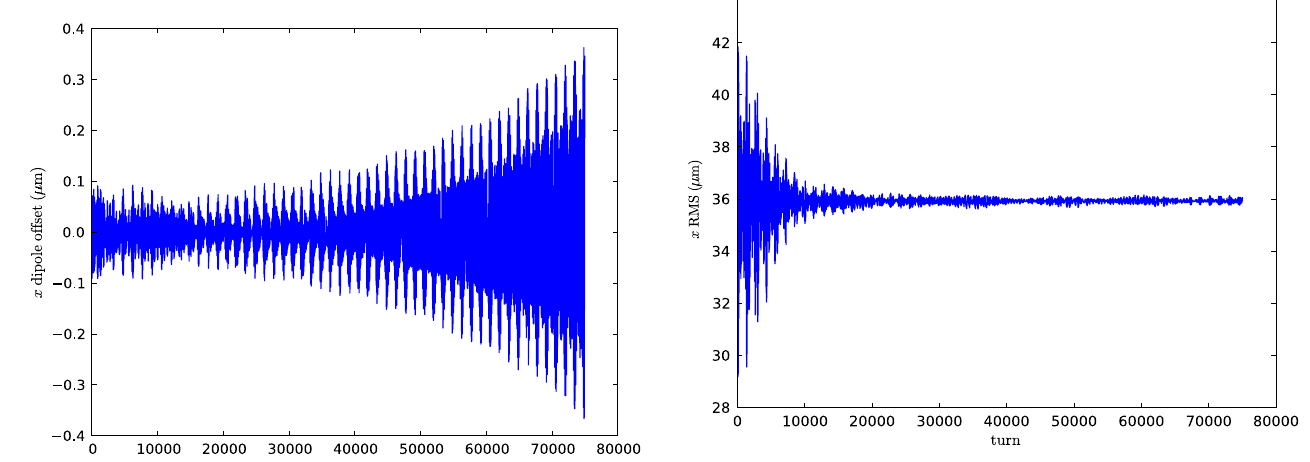
FIG. 17. (Color) The x dipole moment in a simulation with C ¼ (cid:1) 2 and no beam-beam effect showing the development of instability.